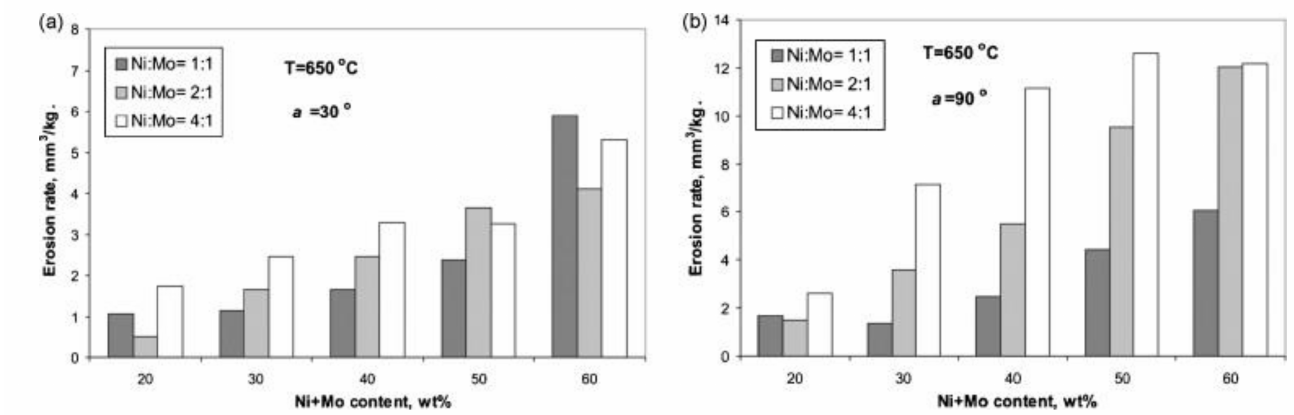
Figure 15. Erosion rate of TiC-NiMo cermets at 650 ◦ C vs. NiMo content, NiMo ratio and impact angle of ( a ) 30 ◦ and ( b ) 90 ◦ (SiO 2 abrasive jet velocity 50 m/s)